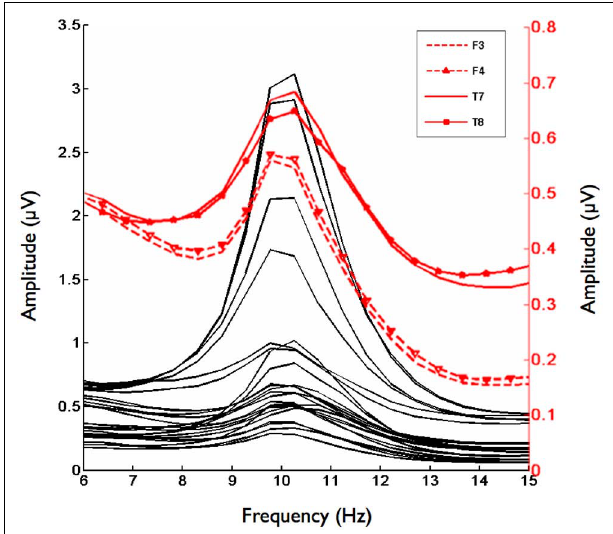
FIGURE 2 | Grand mean for the frequency range from 6–15 Hz for 29 Electrodes. Red lines indicate homologous electrode sites at which asymmetry scores significantly correlated with the implicit affiliation motive. Black lines indicate remaining electrode